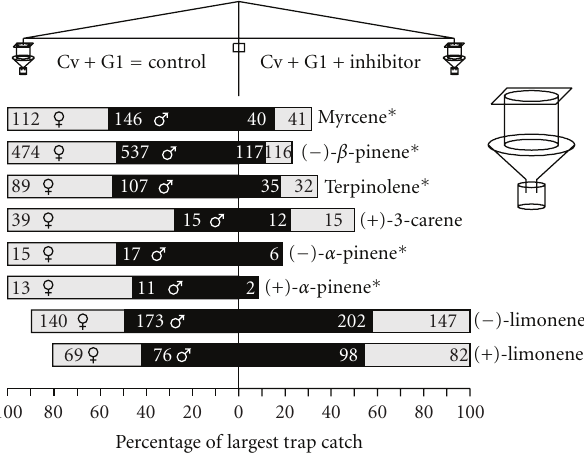
Figure 2: Attraction of flying Pityogenes bidentatus to pairs of slowly-rotated traps releasing aggregation pheromone ( cis - verbenol = Cv and grandisol = G1) when individual monoterpenes were released from one of the two traps. Tests were performed at di ff erent dates and times during May 2001 in Sj¨obo/Veber¨od, Sweden. Numbers inside light and black bars represent catch of each sex. Treatments with asterisks caught significantly fewer beetles (sexes summed) in the treatment than the control trap in the same pair ( P < 0 . 01, chi-square